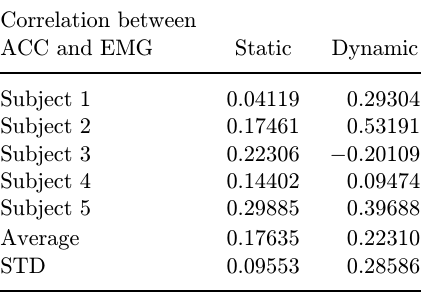
Table 1. Correlation between ACC and EMG during static and dynamics